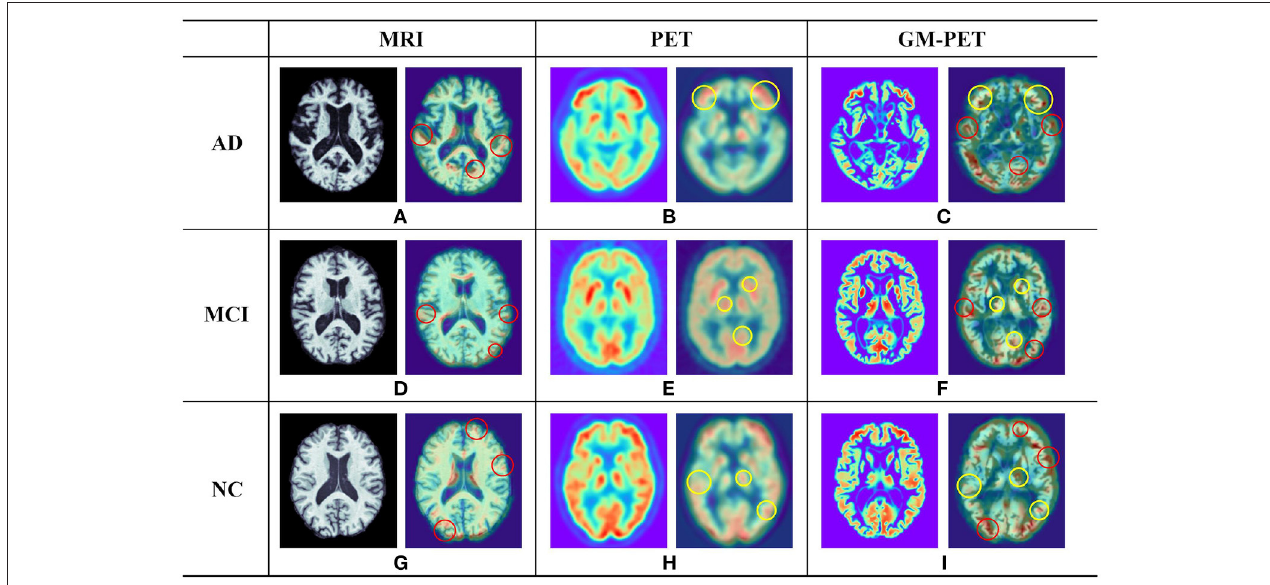
FIGURE 6 | Examples of different modality images for AD, MCI, and NC subjects. In each of the nine cells (A–I) , the picture on the left is a subject slice and the picture on the right is the Grad-CAM result for that slice. The red circle in the 3D Grad-CAM results outlines the contour areas of common interest in the MRI and GM-PET images, while the yellow circle outlines the metabolic characteristic areas of common interest in the PET and GM-PET